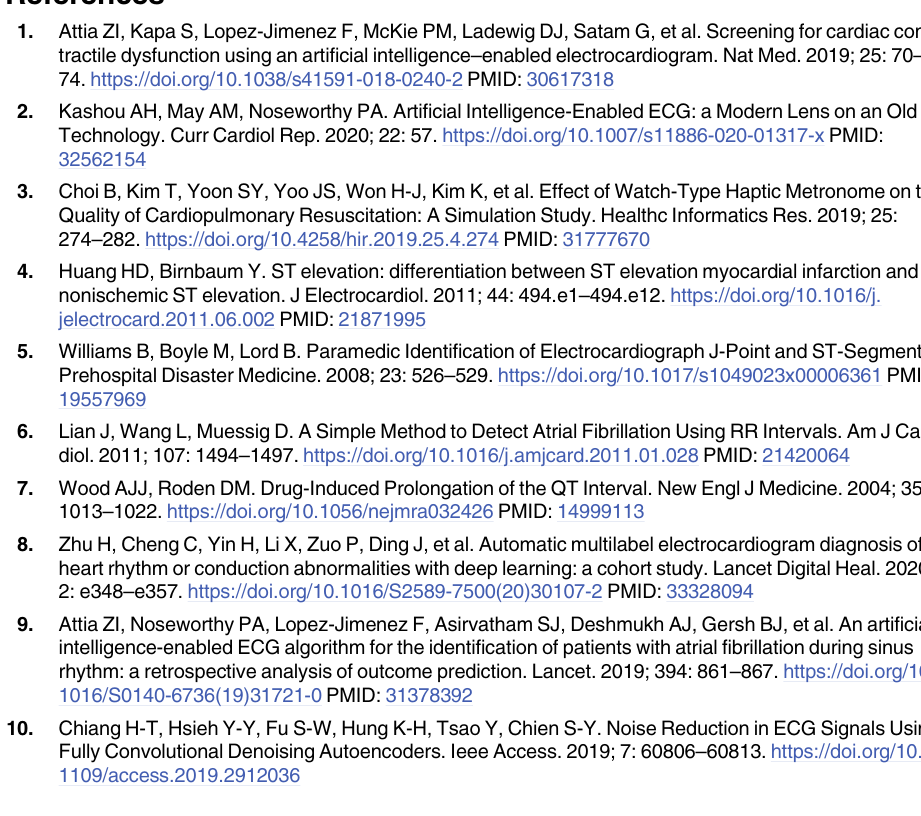
S3 Fig. Structure of transfer learning of weight initialization. S1 Table. Detailed results of classification of 11 rhythms using XGBoost. S2 Table. Feature importance of XGBoost. S3 Table. Classification of arrhythmias in the Shaoxing dataset using weight initialization of transfer